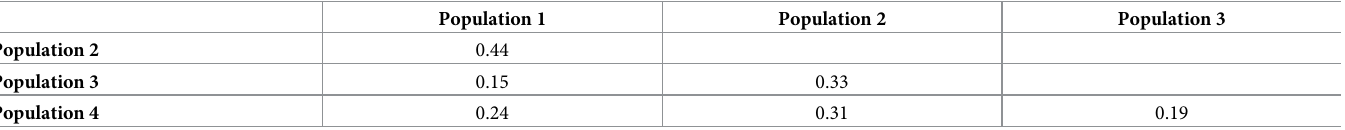
Table 1. Pairwise estimates of F ST in NPGS Senegal sorghum populations based on the analysis of 221 SSR